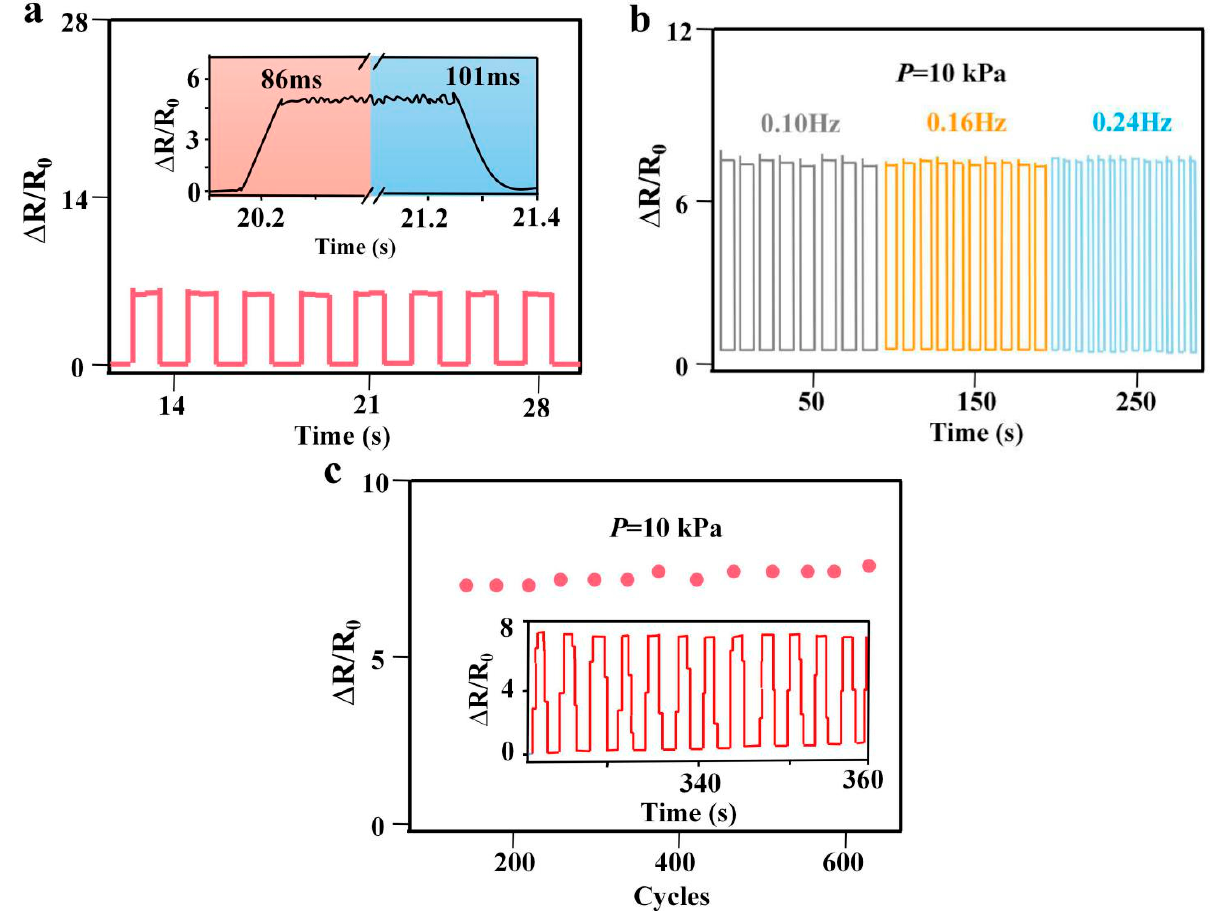
Figure 6. ( a ) Response time and recovery time of the CCP/LIG sensor; ( b ) relative resistance change of CCP/LIG at different frequencies at a pressure of 10 kPa; ( c ) CCP/LIG durability test at a pressure of 10 kPa.